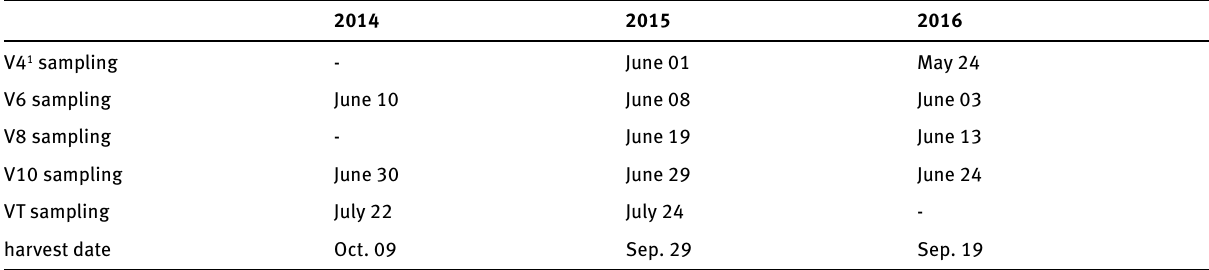
Table 2: Biomass samplings at the Hollage